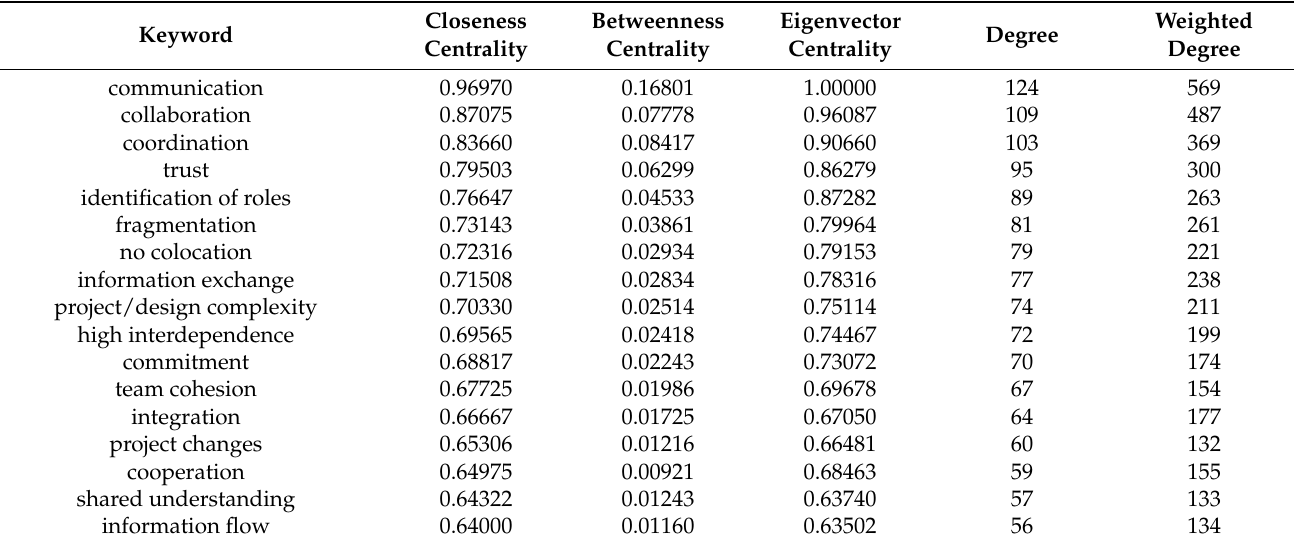
Table 5. Metrics of the main problems in the selected